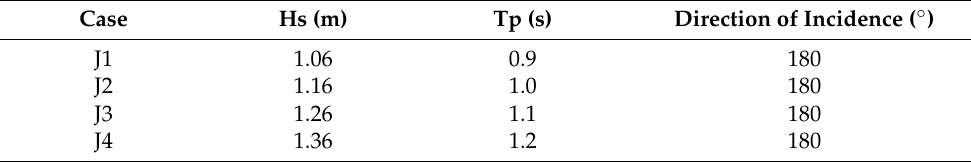
Table 3. Working conditions of the irregular wave (JONSWAP